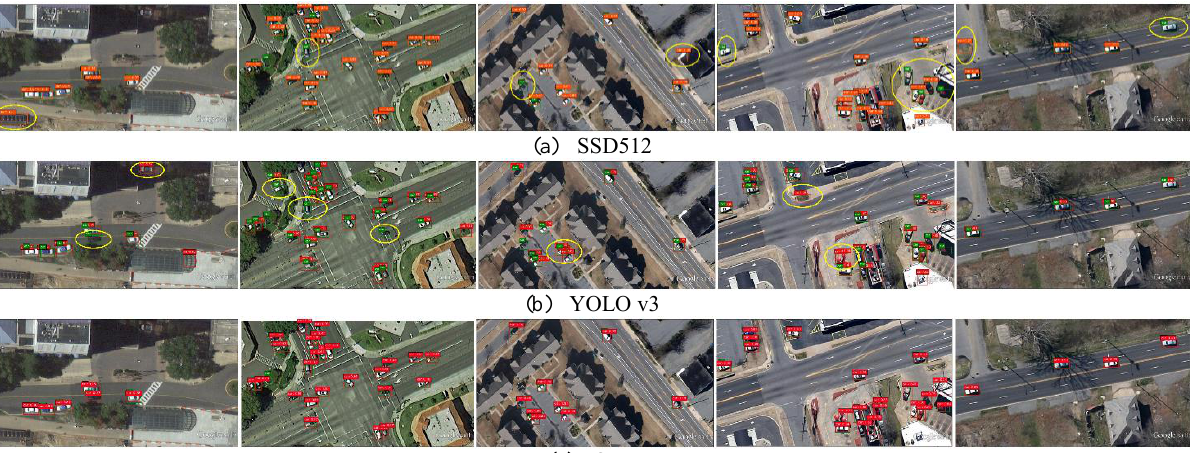
Figure 6.The result of (a) SSD512, (b) YOLO v3 and (c) Ours. From the figure (a) (b), there are many missing and false detection in the results of SSD and Yolo, and the detection result is poor in the detection of some smaller vehicles. Although our method has some problems in some areas with dense vehicles, the overall performance is better, and the smaller vehicles can also be accurately